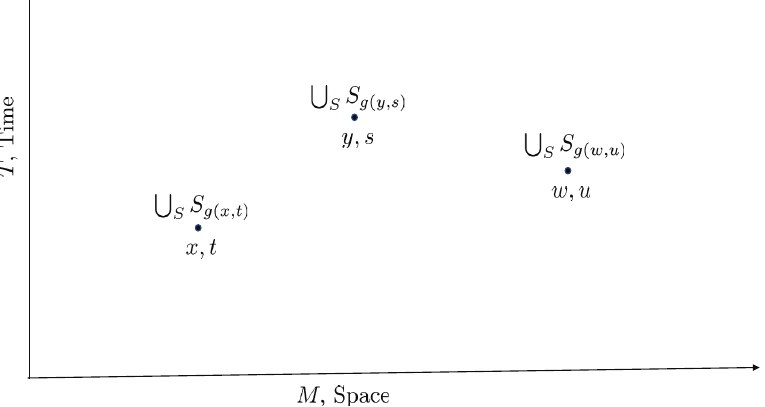
Figure 1. Illustration of the existence of local mathematics at each point in space and time. The illustration is for three locations, x , t , y , s , and w , u.